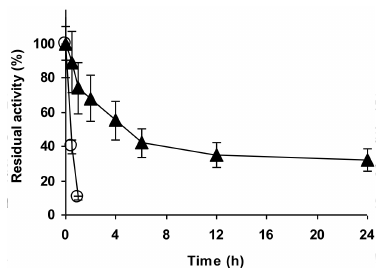
Figure 7. Modification of glyoxyl (triangles) or MANAE agarose (circles) immobilized ficin extract when incubated in 1% glutaraldehyde at pH 7. Experiments were performed as described in Methods using BANA as substrate.